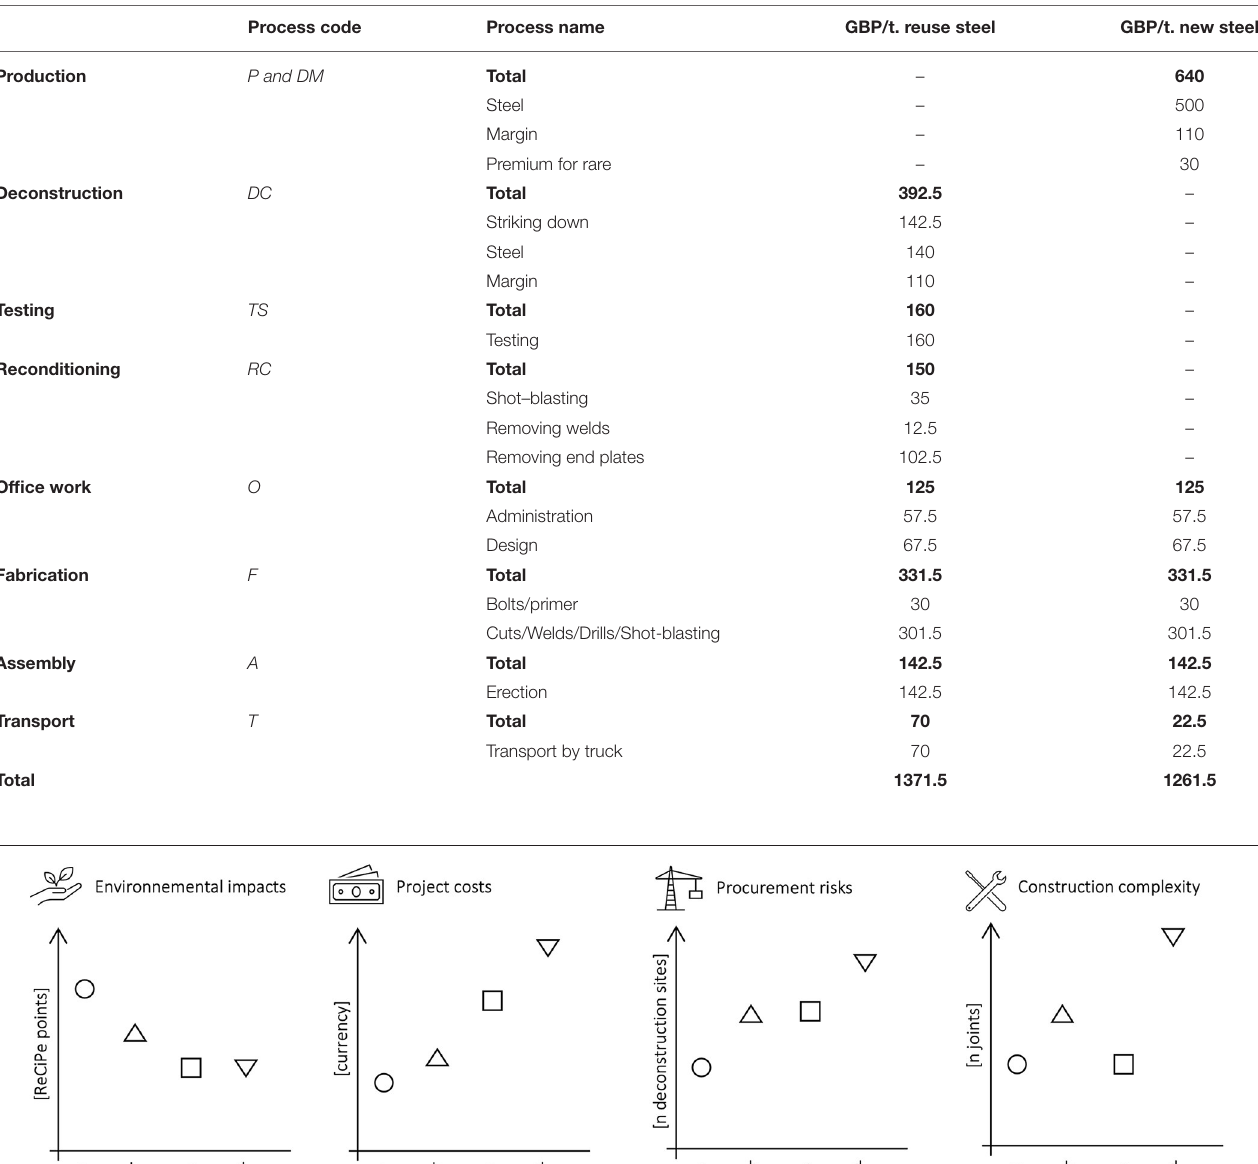
TABLE 2 | Costs of “new” and “reuse” route processes, adapted from Dunant et al. (2018).